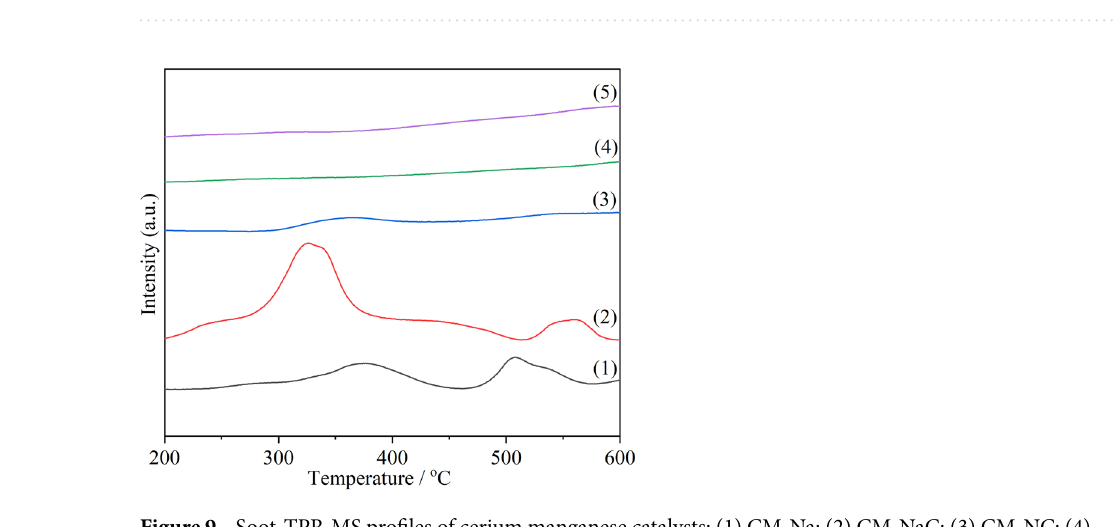
Figure 9. Soot-TPR-MS profiles of cerium manganese catalysts: (1) CM-Na; (2) CM-NaC; (3) CM-NC; (4) CM-N; (5)